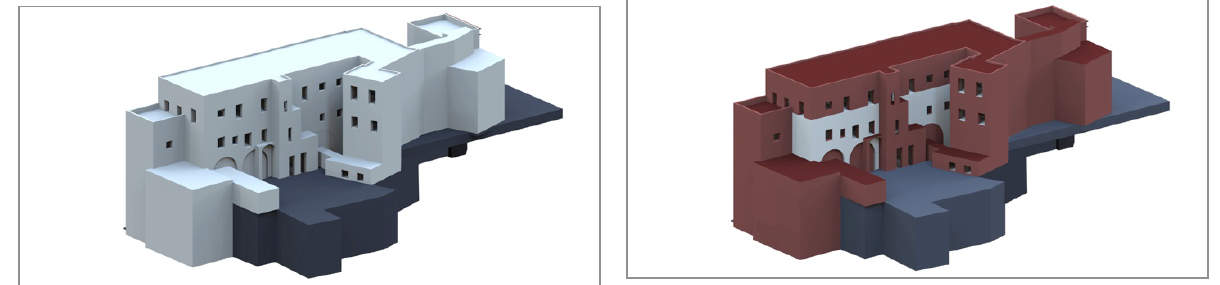
Figure 8. Palazzo Penne, view of the internal courtyard, eighteenth-century additions Modeling by S. Scandurra